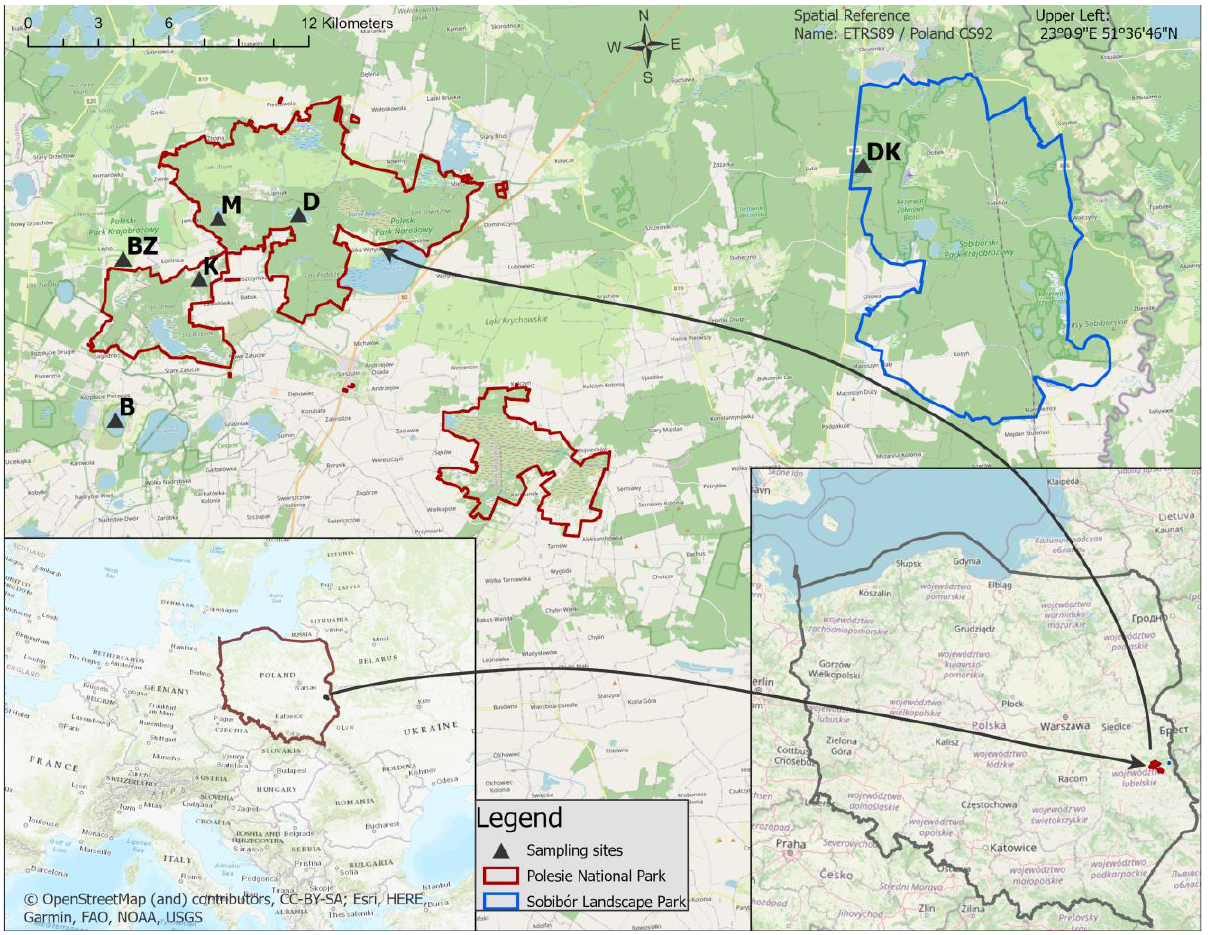
Figure 1. Location of the study and sampling sites in the Polesie Podlaskie region: Lake Bikcze (B), Lake Karaśne (K), Lake Długie (D), Lake Moszne (M), the mid-forest bog Blizionki (BZ) and the Dekowina (DK) wetland